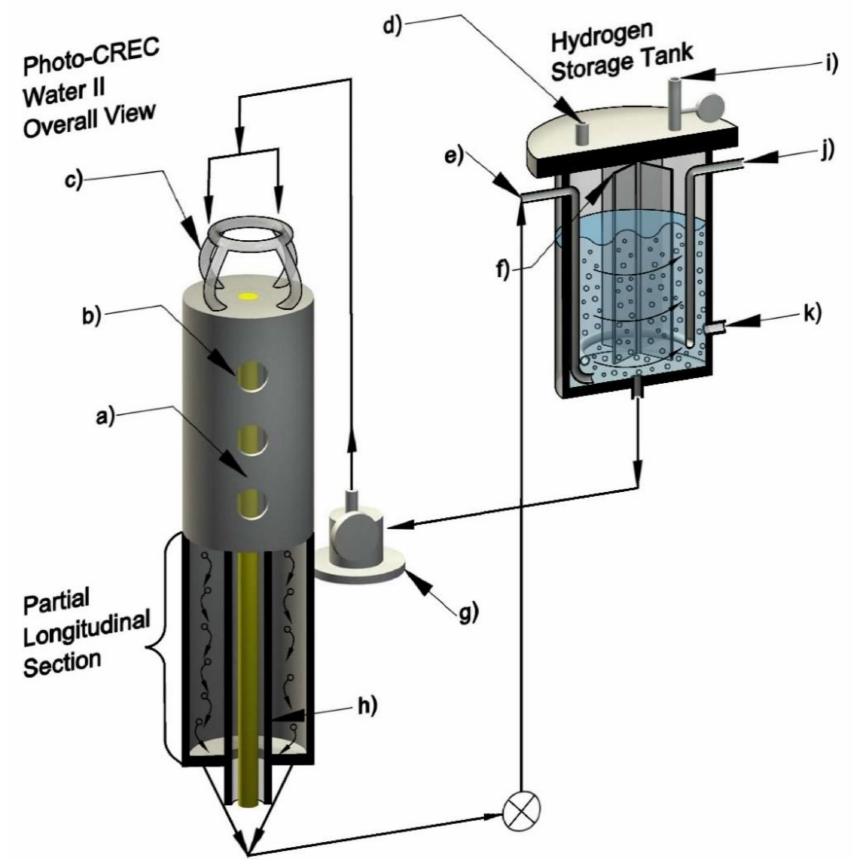
Figure 13. Schematics of the Photo-CREC Water II Reactor. Components: ( a ) Opaque polyethylene tube, ( b ) Fused silica windows, ( c ) Flow distributor, ( d ) Gas sampling port, ( e ) Jet driving mixing port, ( f ) Self-driven mixing impeller, ( g ) Centrifugal pump, ( h ) Pyrex tube, ( i ) Draining gas valve, ( j ) Purging gas injector, and ( k ) Slurry sampling